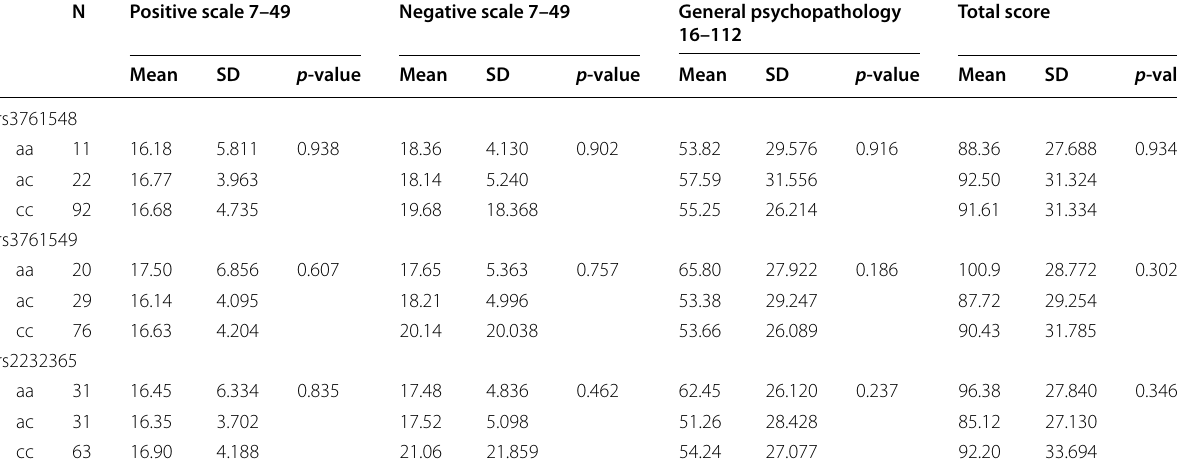
Table 5 Association of the FOXP3 SNPs with the PANSS score of schizophrenia